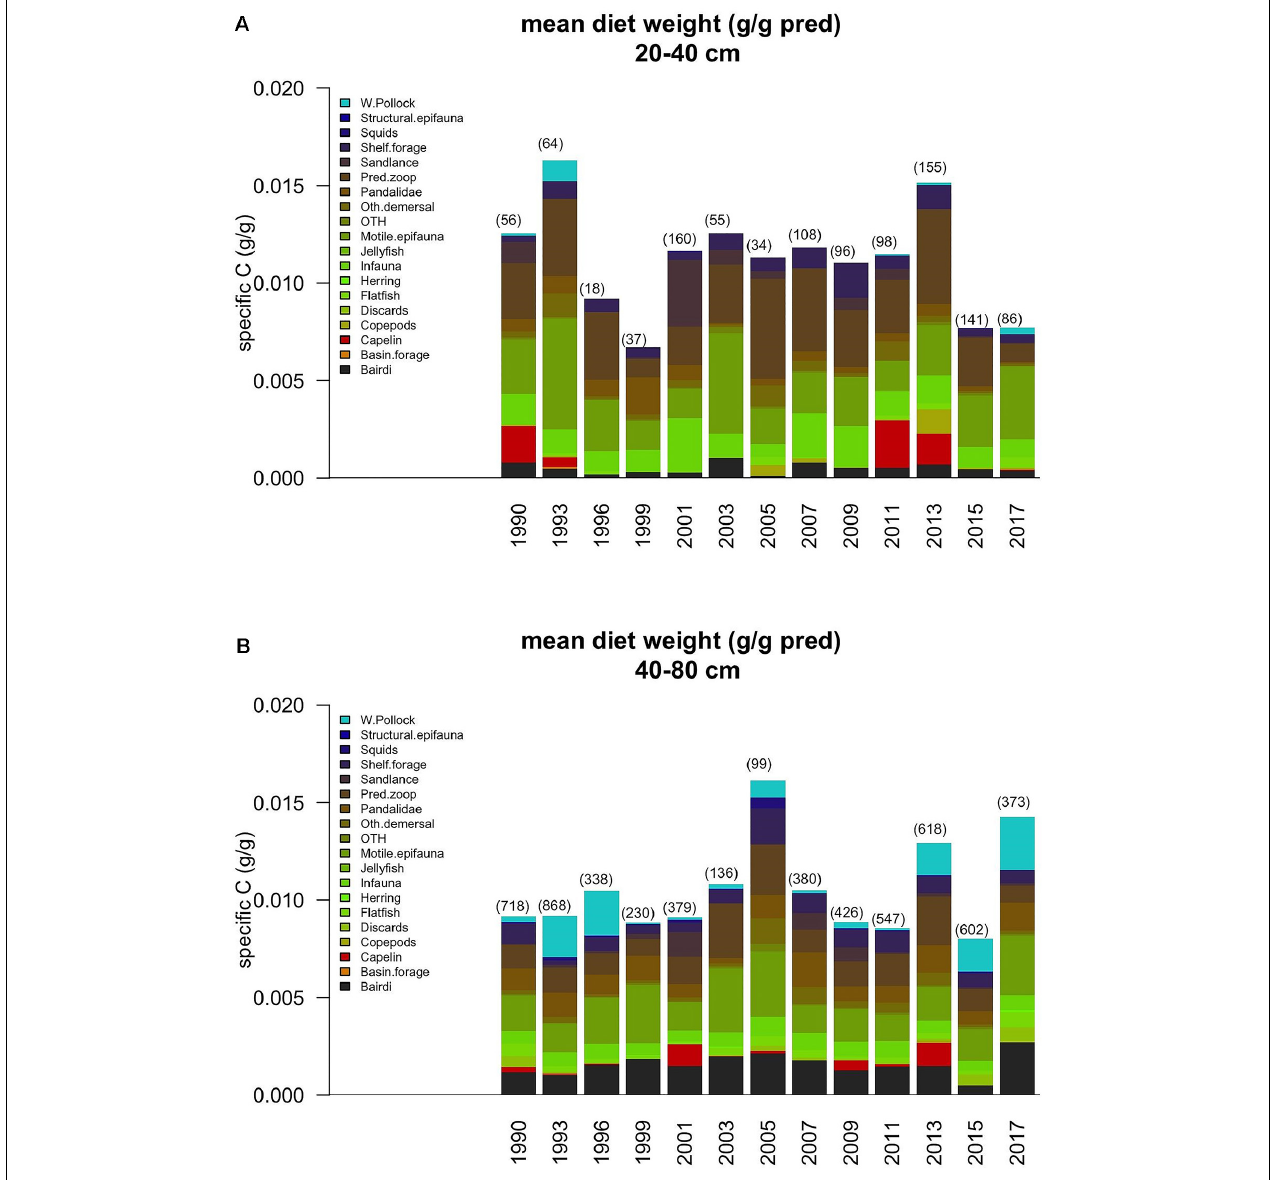
FIGURE 3 | Specific weight (g prey/g pred) of prey in the diets of GOA Pacific cod, averaged across all survey diet samples and prey sizes for (A) 20–40 cm and (B) 40–80 cm fish. The 2019 index value is the sum through 26 February